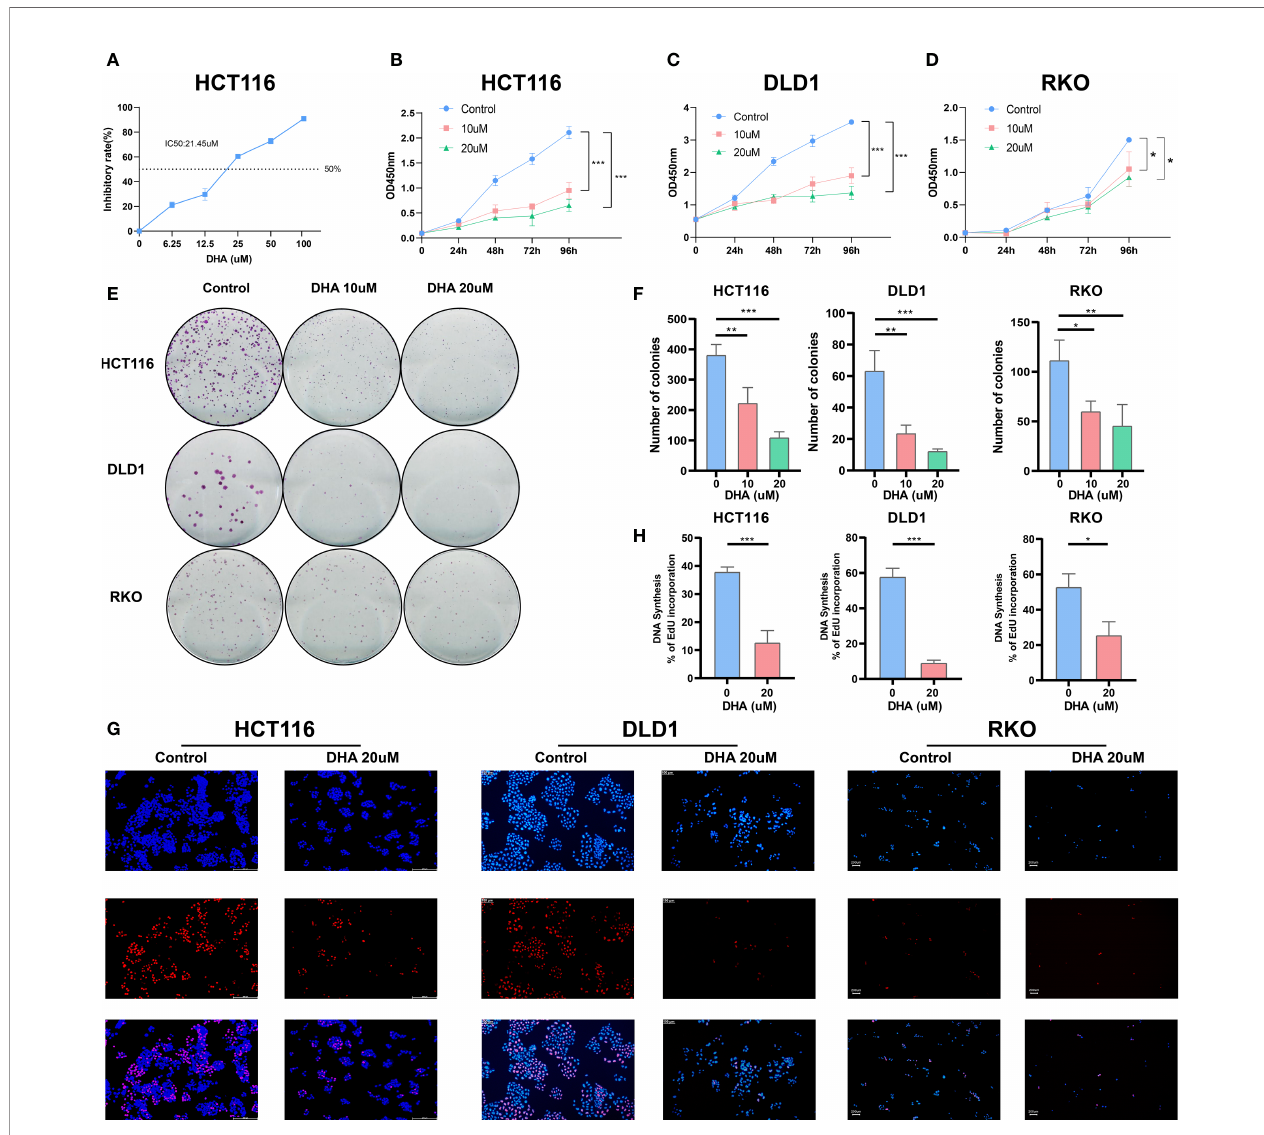
FIGURE 1 | DHA inhibited the proliferation, colony formation, and DNA synthesis in CRC cells. (A) The IC 50 of DHA was detected by the CCK8 assay in HCT116 cells. (B – D) The effects of DHA on cell viabilities were examined by the CCK8 assay. (E, F) The effects of DHA on cell colony formation were illustrated by the cell colony formation assay. (G, H) The effects of DHA on DNA synthesis were examined by the EdU assay. Data are shown as means ± SD. *p < 0.05, **p < 0.01, ***p < 0.001. DHA, dihydroartemisinin; CRC, colorectal